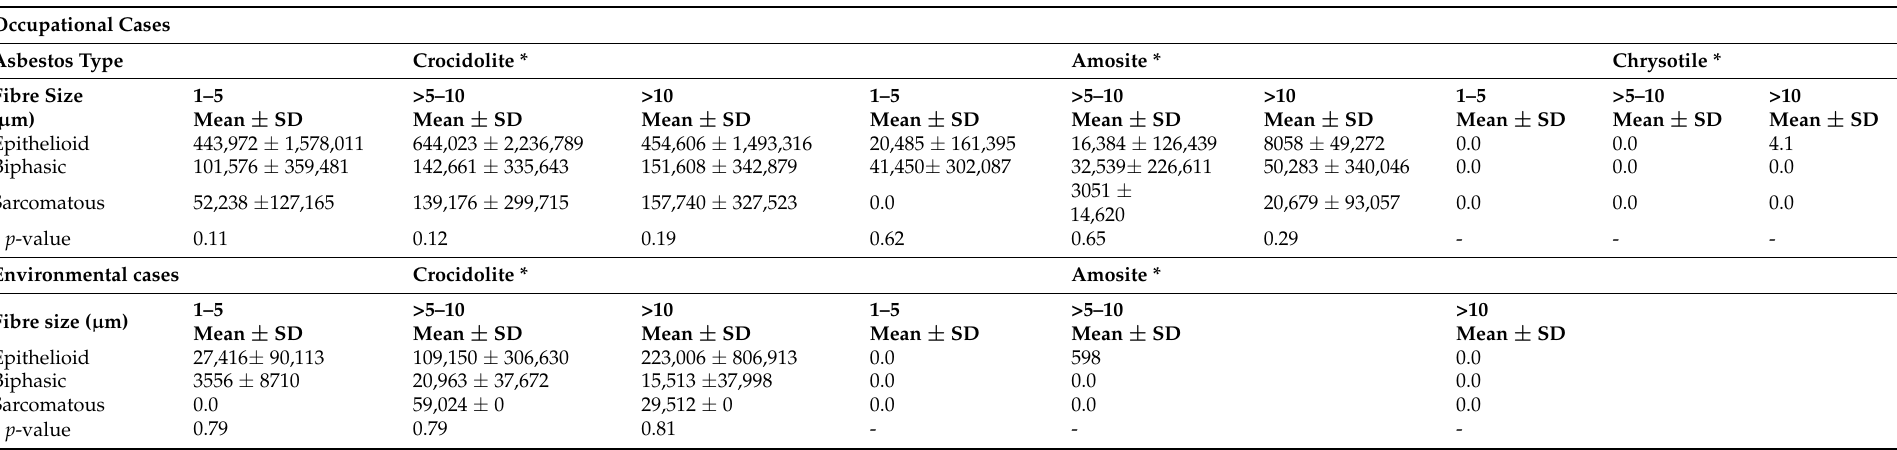
Table 8. Mean concentration of fibre sizes per mesothelioma subtype (millions per gm of dried lung, µ